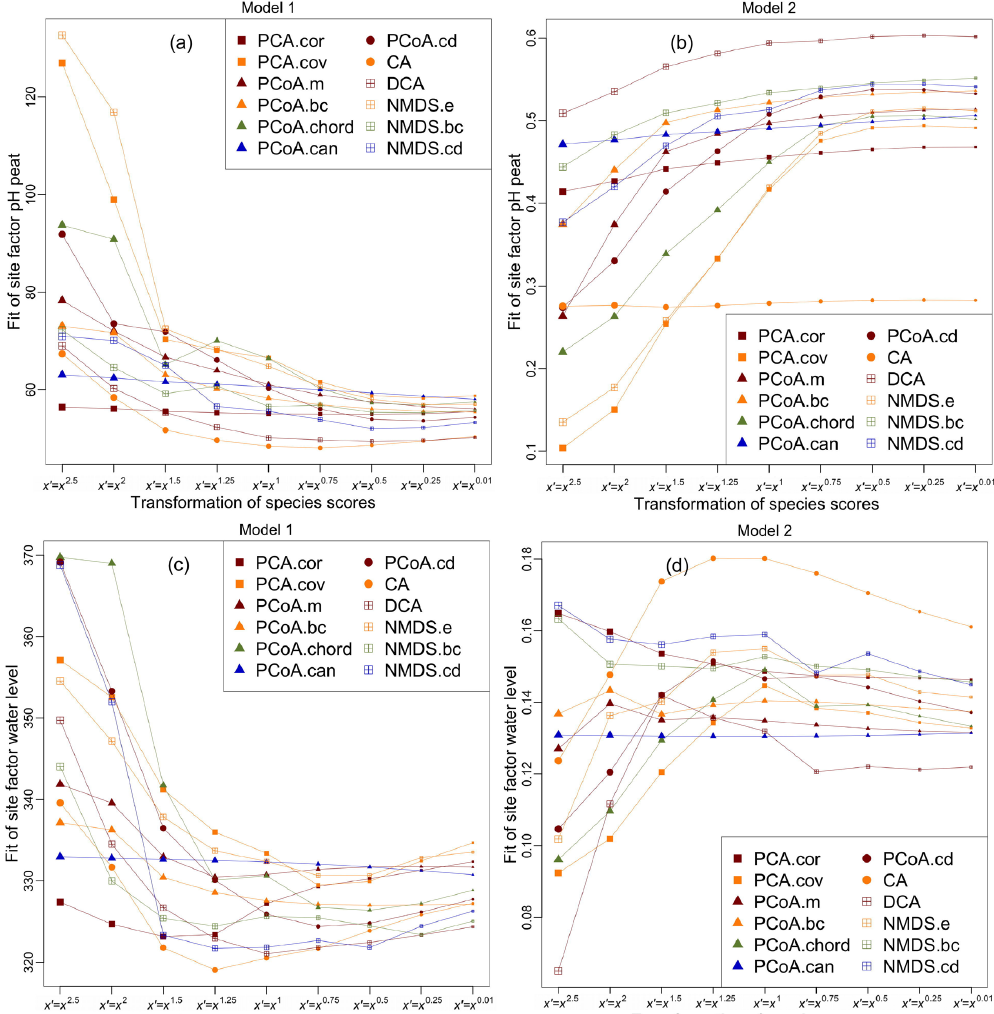
than the same in panel (b).